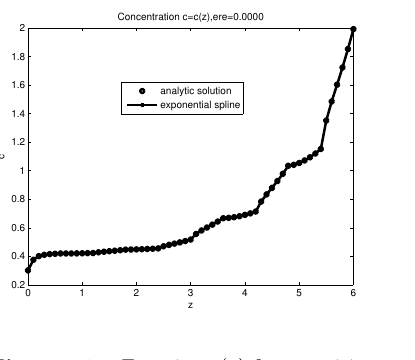
Figure 14. Function c ( z ) for a negative source